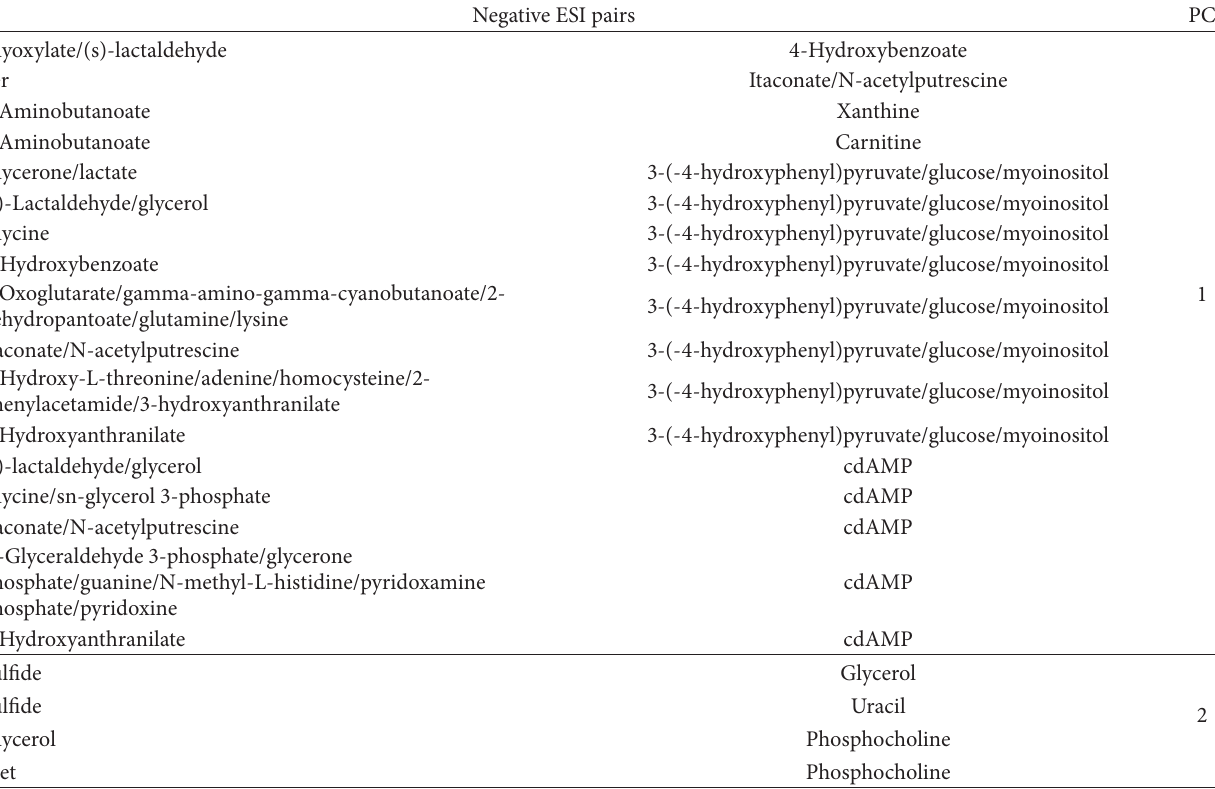
Table 4: List of major metabolites (significantly correlate response over time in the different C-source) by negative ESI mode.